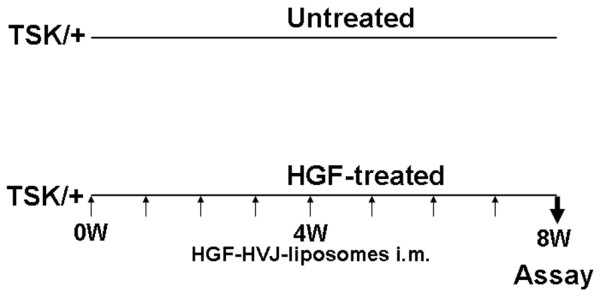
Experimental protocol for injection of HGF-HVJ liposomes into TSK/+ mice. Treatment consisted of once-weekly injection of either HGF-HVJ liposomes or control mock vector for a period of 8 weeks. Treatment was initiated at the age of 4 weeks. Histopathology and cytokine mRNA expression in the spleen, skin, and lungs was examined 8 weeks after treatment. HGF, hepatocyte growth factor; HVJ, hemagglutinating virus of Japan; im, intramuscular; TSK/+, tight skin.